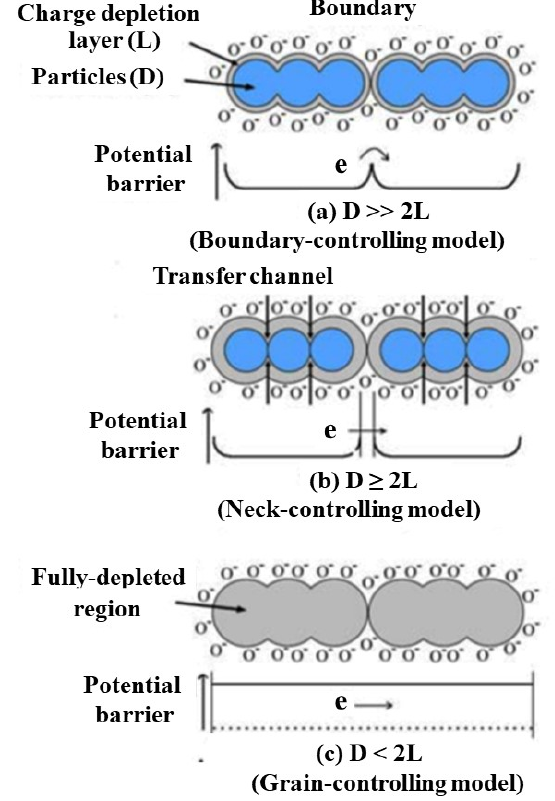
Figure 4. Schematic model of the effect of the crystallite size on the sensitivity of metal-oxide gas sensors: ( a ) D >> 2L, ( b ) D ≥ 2L, and ( c ) D < 2L. Reprinted with permission from Ref. [42]. Copyright 1991 Elsevier.